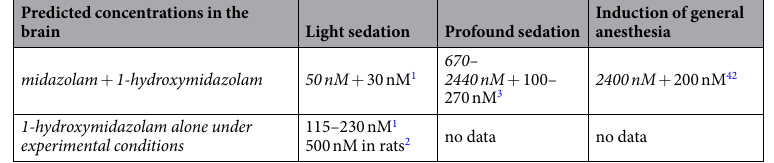
Table 1. Predicted concentrations of midazolam and 1-hydroxymidazolam in the brain, corresponding to the level of sedation. The second row summarizes plasma concentrations taken from clinical studies, where 1-hydroxymidazolam is a product of metabolism of midazolam. The third row reports data where 1-hydroxmidazolam was given alone, i.e., in the absence of midazolam. Meanwhile, a study by Bremer et al . demonstrated in critically ill patients plasma concentrations ranging from 60 to 136 ng/ml for midazolam and from 11 to 62.5 ng/ml for 1-hydroxymidazolam for lightly sedated patients as well as plasma concentrations ranging from 307 to 1106 ng/ml for midazolam and from 41 to 119 ng/ml for 1-hydroxymidazolam for deeply sedated patients 3 . Taking into account the molecular weights of the two compounds, midazolam’s free unbound fraction of approximately 3% 1 and the brain-to-unbound-serum concentration ratio of almost 34 43 , this would correspond to a midazolam concentration of about 130 to 2,400 nM in the central nervous system. In the case of 1-hydroxymidazolam, the free unbound fraction is supposed to be 10% 1 and the brain-to-unbound-serum concentration ratio around 8 43 . Thus, the concentration of 1-hydroxymidazolam in the central nervous system should range from 25 to 270 nM. These assumptions are in accordance with data from the literature, indicating that nanomolar concentrations of midazolam in vitro are of clinical relevance 18